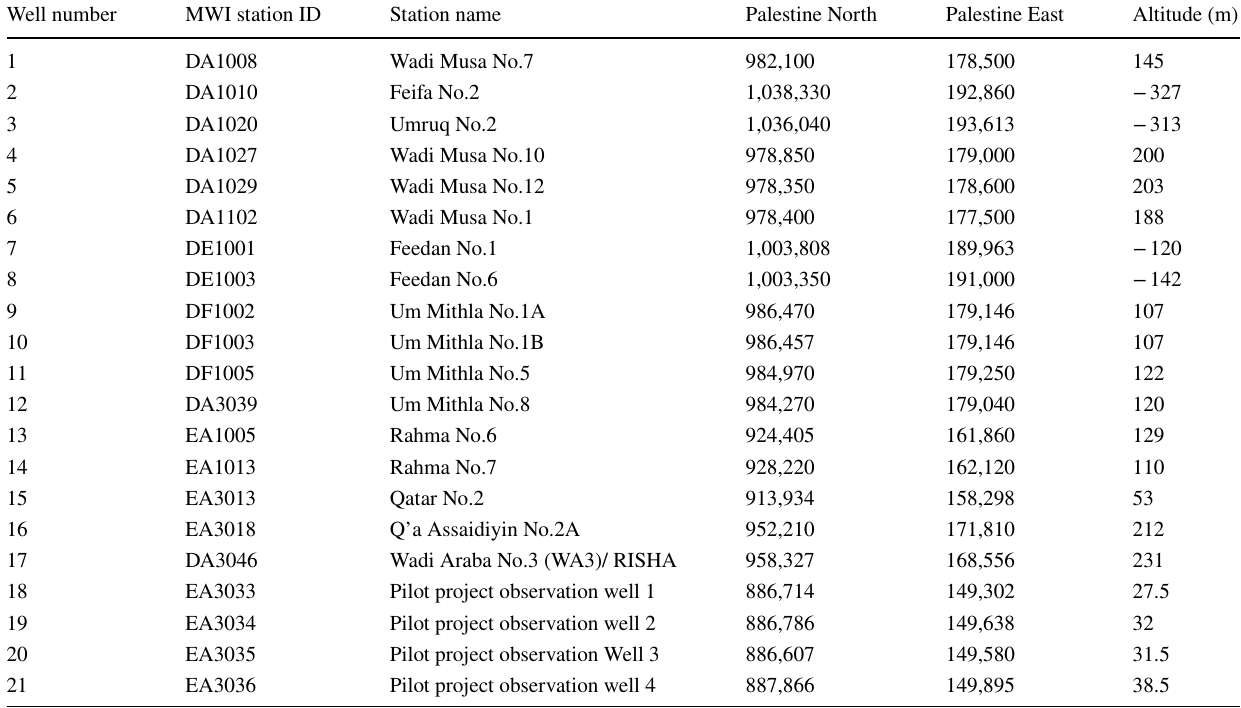
Table 1 Inventory of groundwater sampling wells from alluvial aquifer in Wadi Araba area Well number